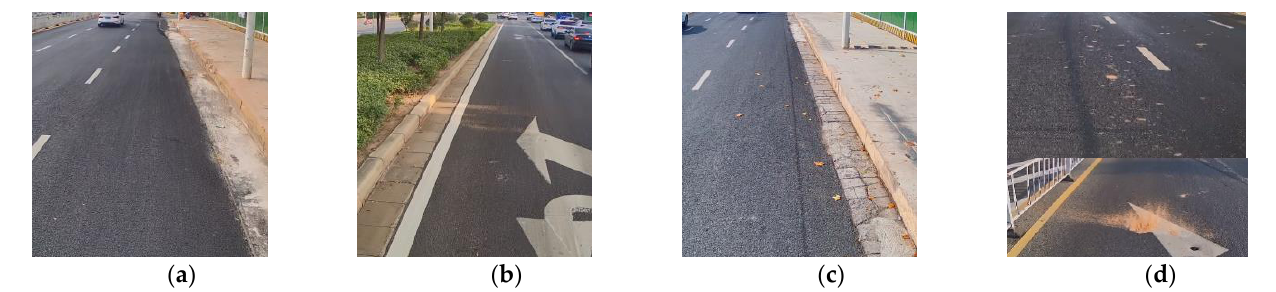
Figure 11. Examples for segments marked with different levels: ( a ) Level 1, ( b ) Level 2, ( c ) Level 3, and ( d ) Level 4.